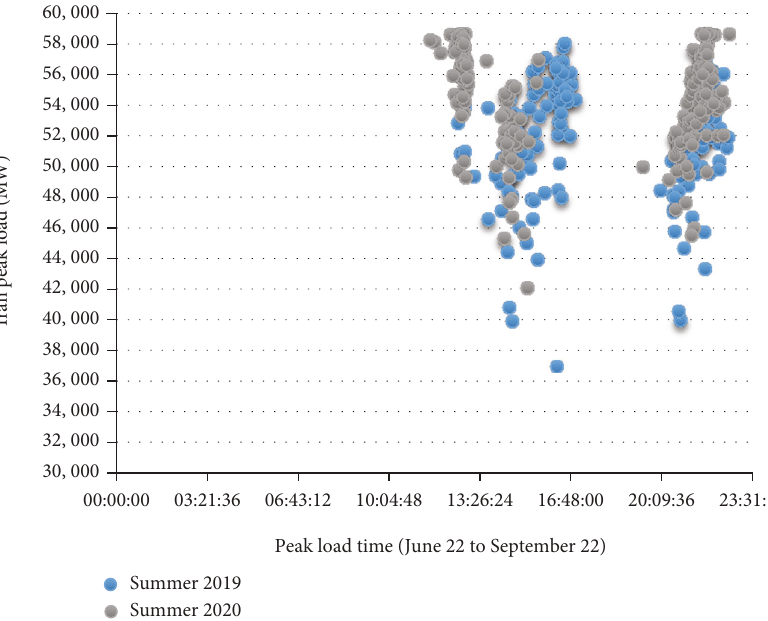
Figure 16: Distribution of day and night peak times in summer 2019 and 2020.